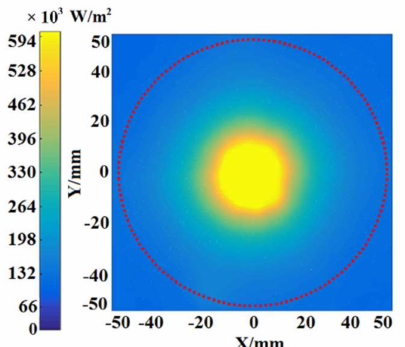
Figure 3. The flux density distribution on the diffuse flat receiver when the Fresnel lens is parallel to the receiver